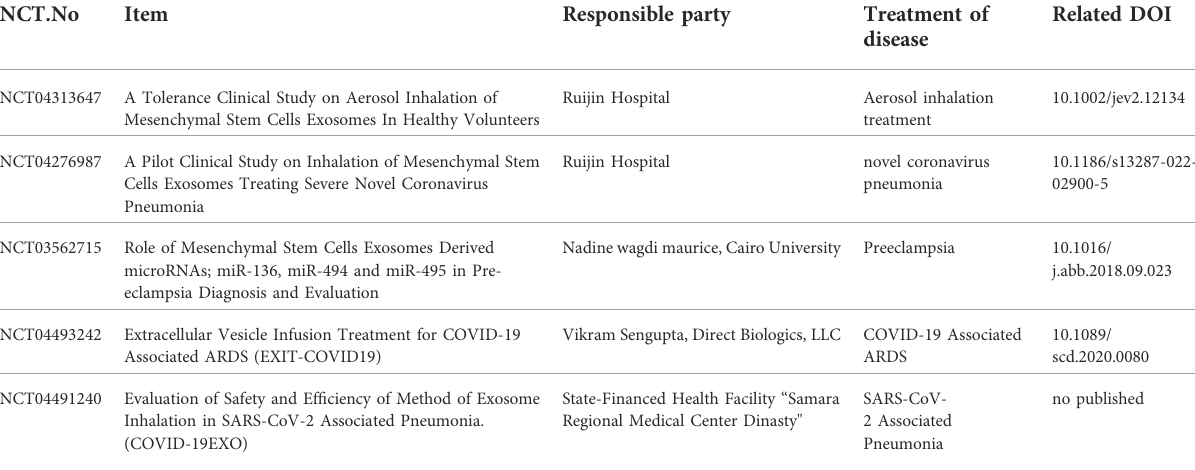
TABLE 1 Clinical studies of mesenchymal stem cell-derived exosomes that were completed up to August 2022 (https://clinicaltrials.gov).